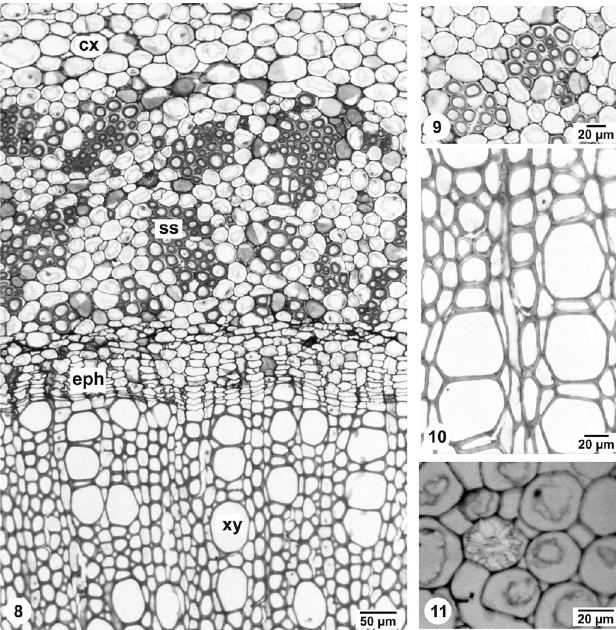
FIGURE 14 - Schema of the stem bark of R. sellowii . Abbreviations: cortex (cx), external phloem (eph), laticiferous ducts (dotted cells), phellogen (phe) and sclerenchymatic sheath